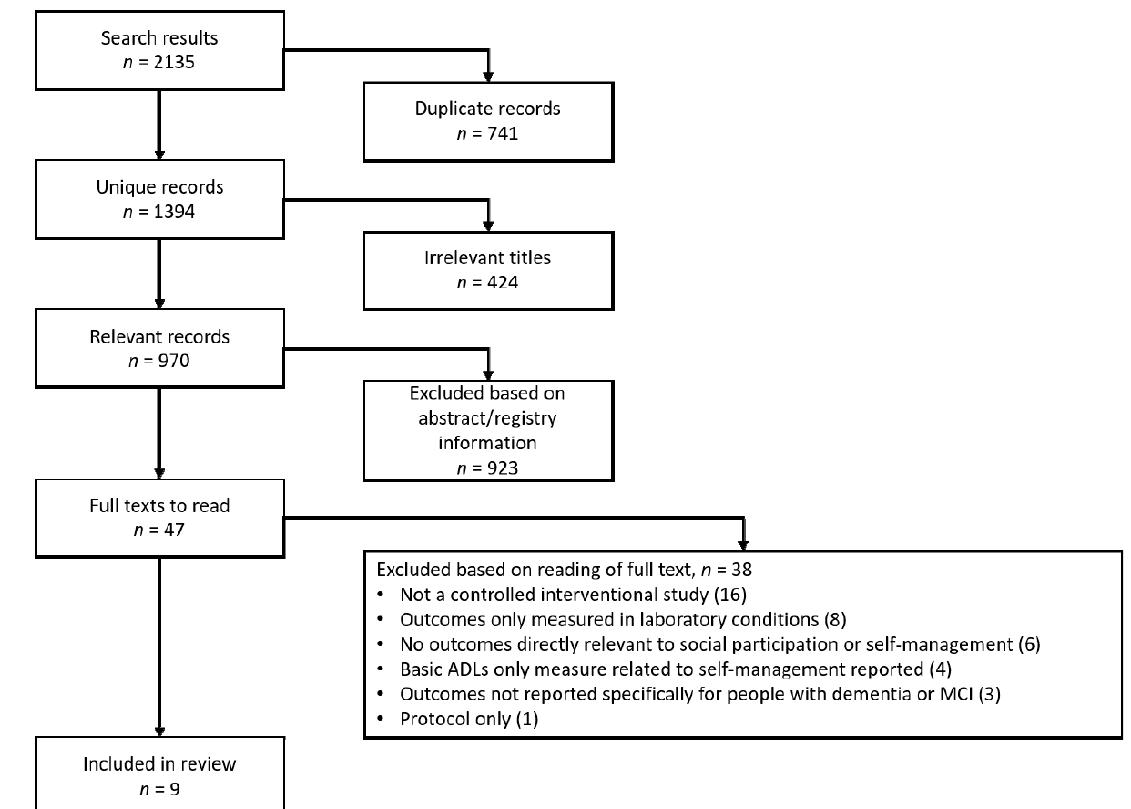
Figure 1. Search result screening process. ADLs: Activities of Daily Living; MCI: Mild Cognitive Impairment.